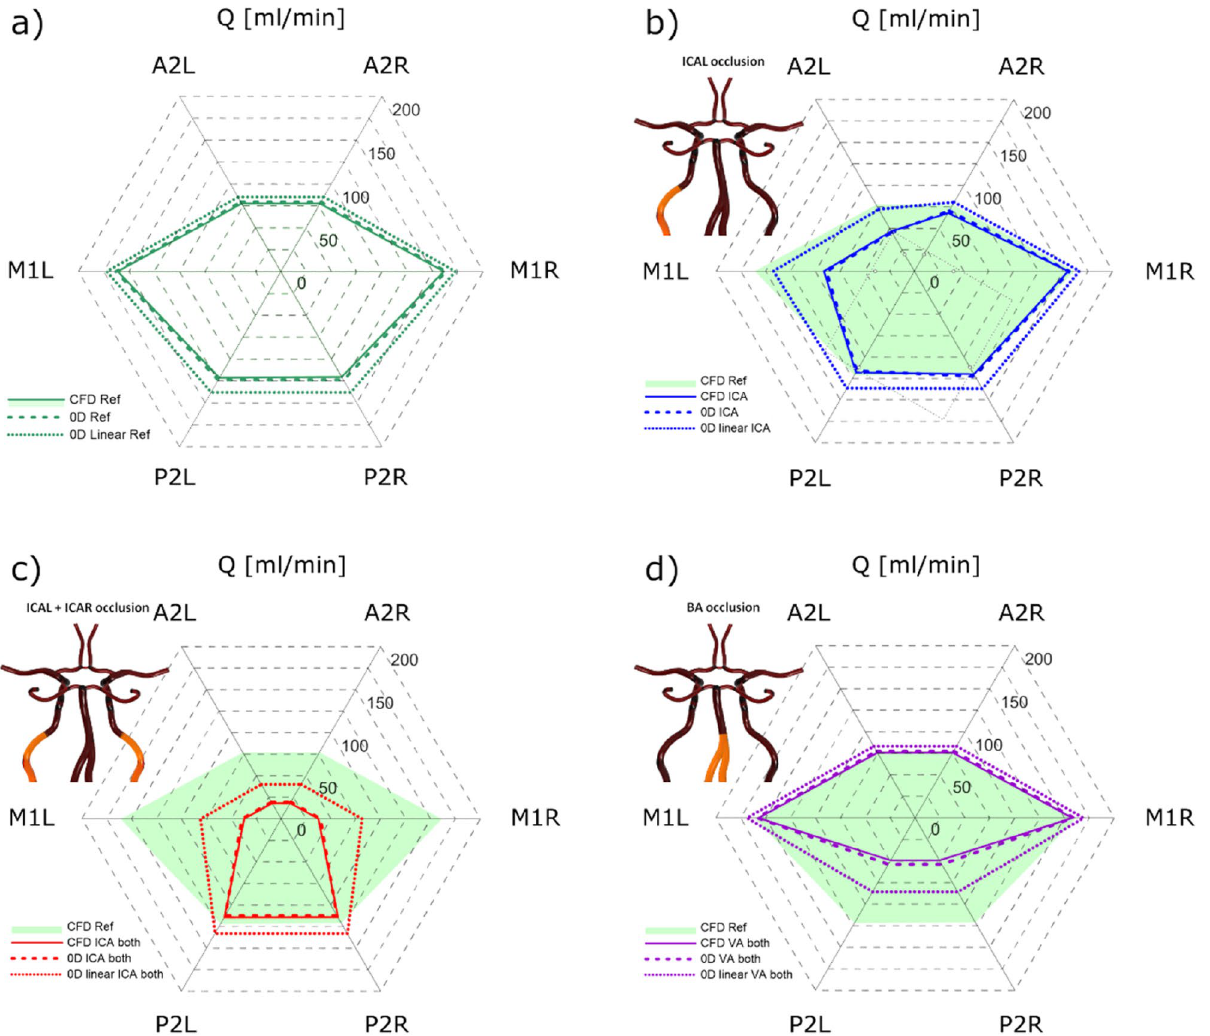
Figure 1. ( a ) A comparison of the flow rates in branches of the reference (physiological) CoW between the CFD model and the 0D models. ( b – d ) A comparison of the flow rates in the CoW branches for the CFD (solid line) and 0D model, nonlinear (dashed line) or linear (dotted line) for different occlusion of supplying arteries configurations (shown as infographics). The green area denotes the CoW without any